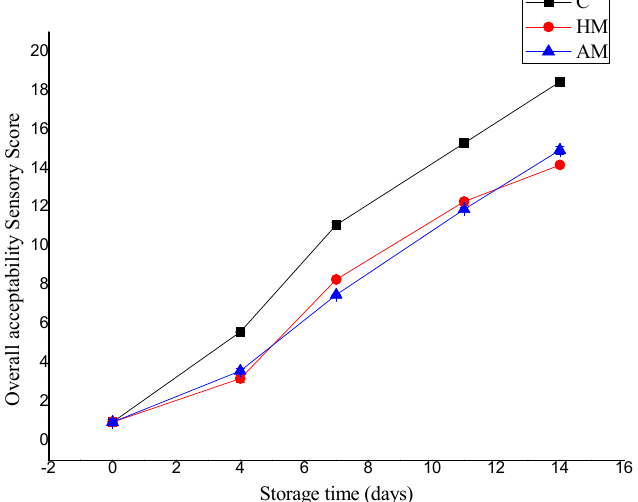
Figure 3. Evaluation of quality score index of control, Hypnea musciformis (HM), and Acanthophora muscoides (AM) treated shrimp muscle relative to days of storage at 0 °C ( n = 3, average ± standard deviation) .